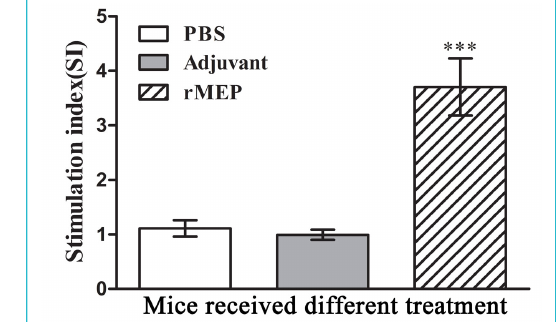
Figure 5: Antigen-specific proliferation of the splenocytes from mice that received different treatments (n = 6). Spleno- cytes were isolated from six mice in each group at day 21 after the third immunisation and cultivated with the stimulation of rMEP. The antigen-specific proliferation of the splenocytes was detected us- ing CCK-8 reagents. Data are shown as the mean of stimulation index (SI) ± SD. *** p <0.001 compared with the PBS- or adjuvant- treated